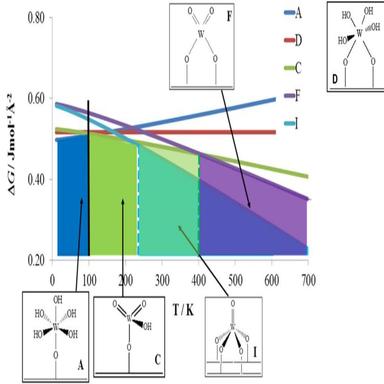
Phase diagram (surface energy vs. temperature) showing the stability ranges for the different grafted W(VI) oxide species (A, C, D, F and I) on the hydroxylated silica surface. Adapted from ref. with permission from The Royal Society of Chemistry.